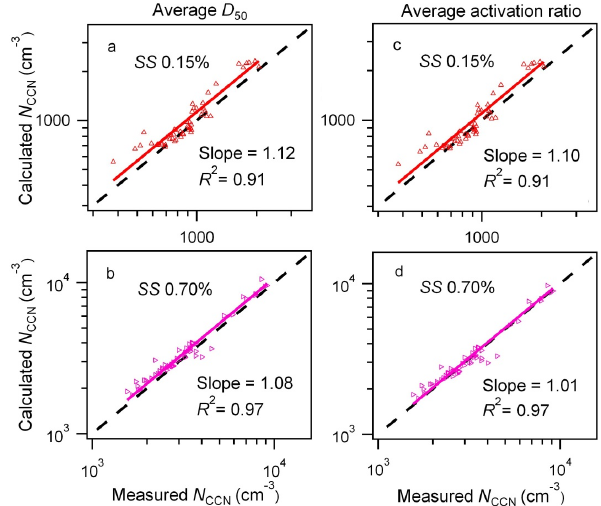
Figure 8. N CCN estimation in hazy period based on ( a and b ) the average D 50 and ( c and d ) the average size-resolved CCN activation ratio from CCN measurement over the hazy